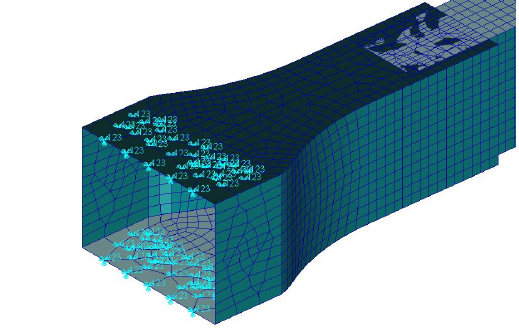
Figure 12. FE model, model setup: Constraint boundary conditions applied on the arm